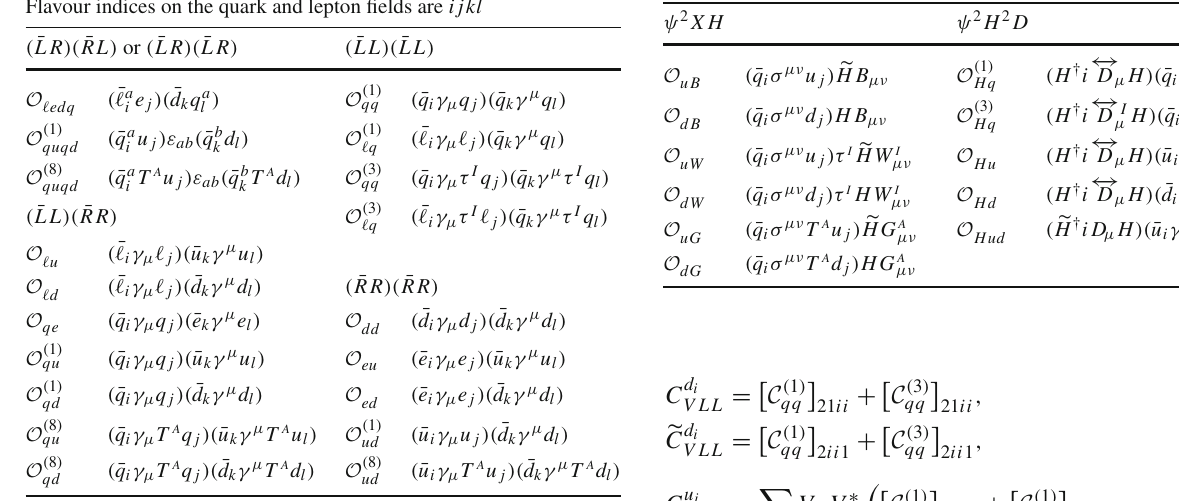
Table 12 Dimension-six electro- and chromo-magnetic dipole ( ψ 2 H X ) and ψ 2 H 2 D operators in